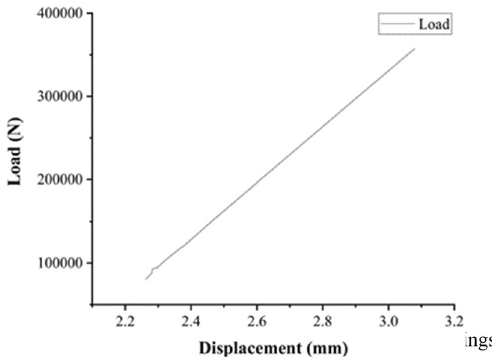
Figure 6. Displacement-load fitting curve for the disc springs.